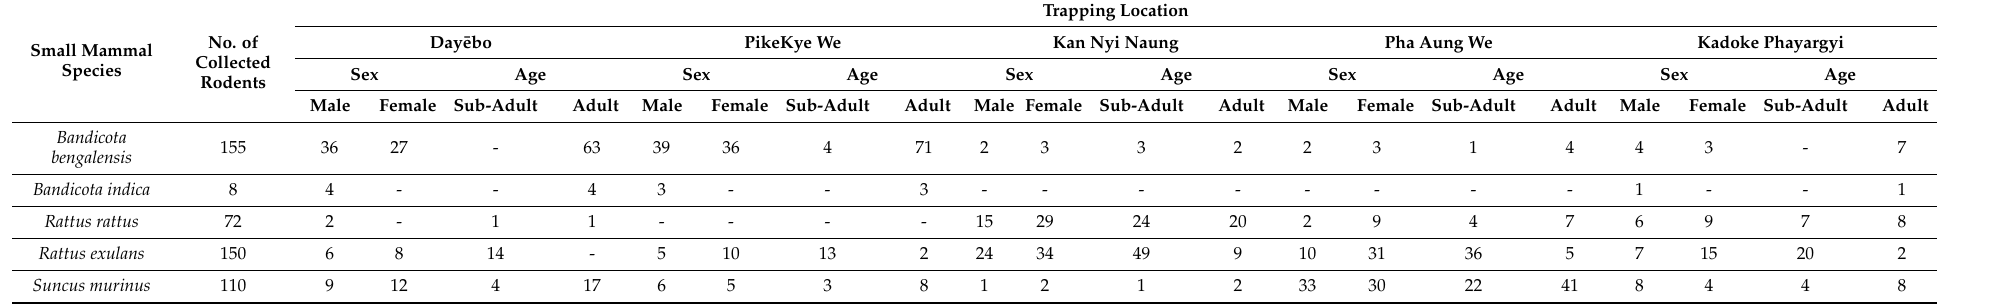
Table 1. Number of small mammal species collected at different study sites from Myanmar.